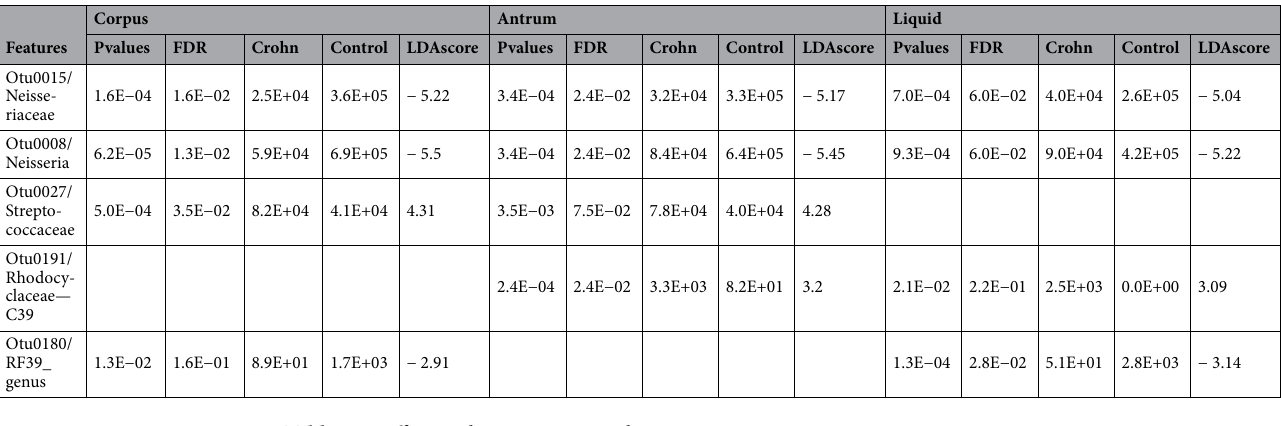
Table 4. Differential taxa in LDA